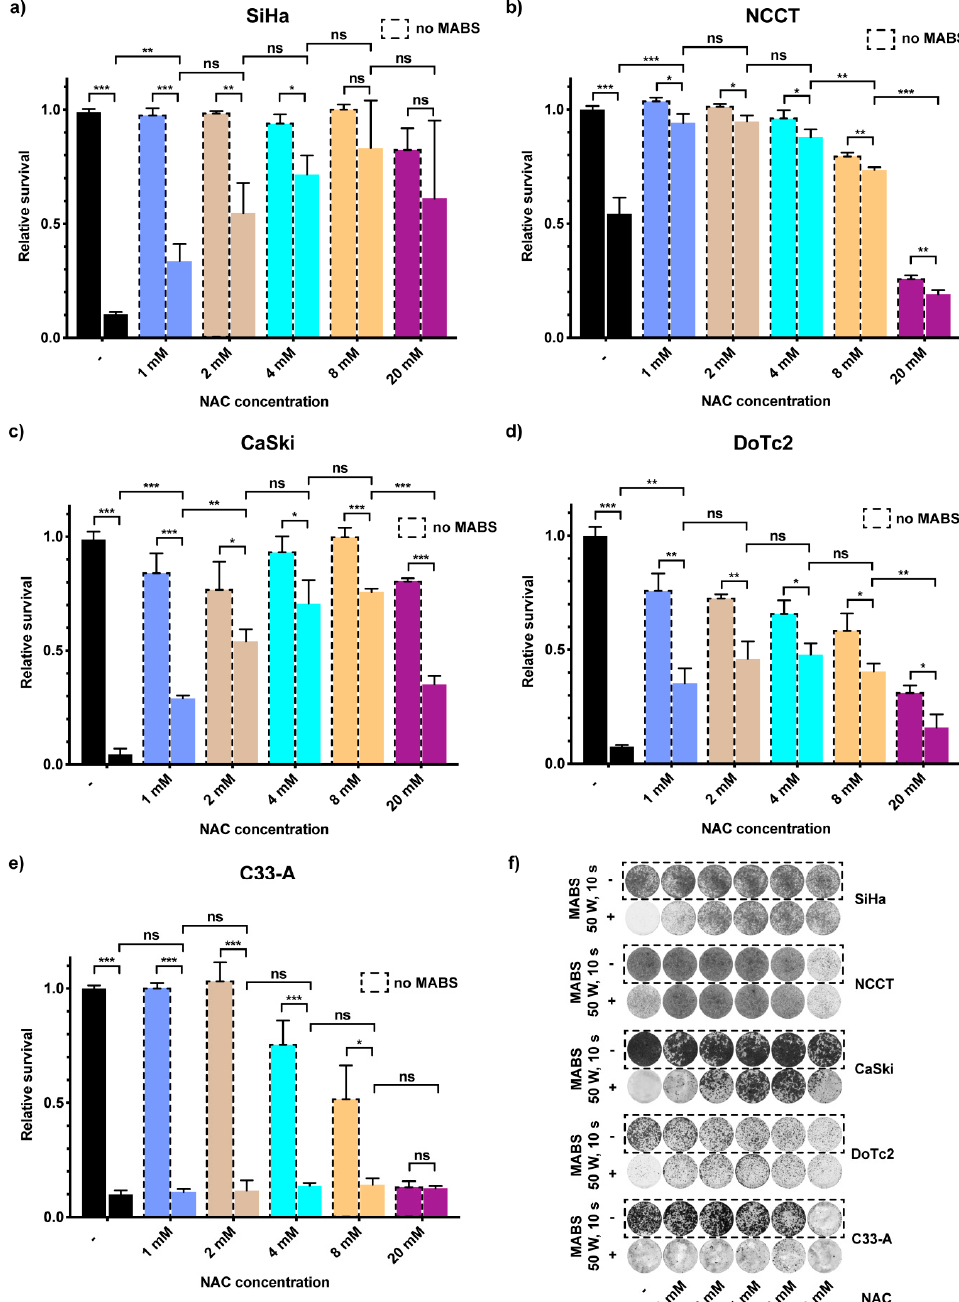
Figure 4. MABS effects are mainly mediated by reactive oxygen and nitrogen species (RONS). Influence of the reactive oxygen species (ROS) scavenger N ‐ acetyl ‐ L ‐ cysteine (NAC) on cell survival of SiHa ( a ), NCCT ( b ), CaSki ( c ), DoTc2 ( d ), and C33 ‐ A ( e ) cells incubated in media supplemented with various NAC concentrations prior to MABS treatment for 10 s with 50 W and fixed and analyzed six days after treatment. The bar diagrams show the average result of the proliferation assay of three independent experiments. ( f ) Crystal violet staining of one representative proliferation assay in cell lines analyzed in ( a – e ). Results are expressed as the mean ± SD of relative survival. * p < 0.05, ** p < 0.01, *** p < 0.001 as determined by Student’s t ‐ test.